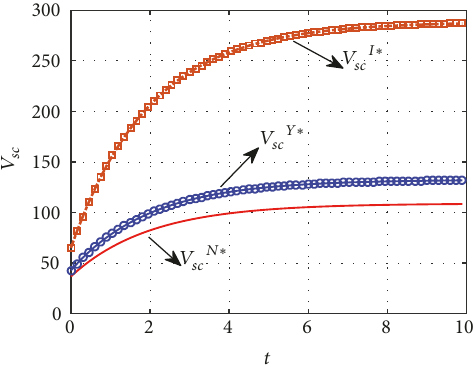
Figure 6: Optimal profit comparison in scenarios 𝑁 , 𝑌 , and 𝐼 .